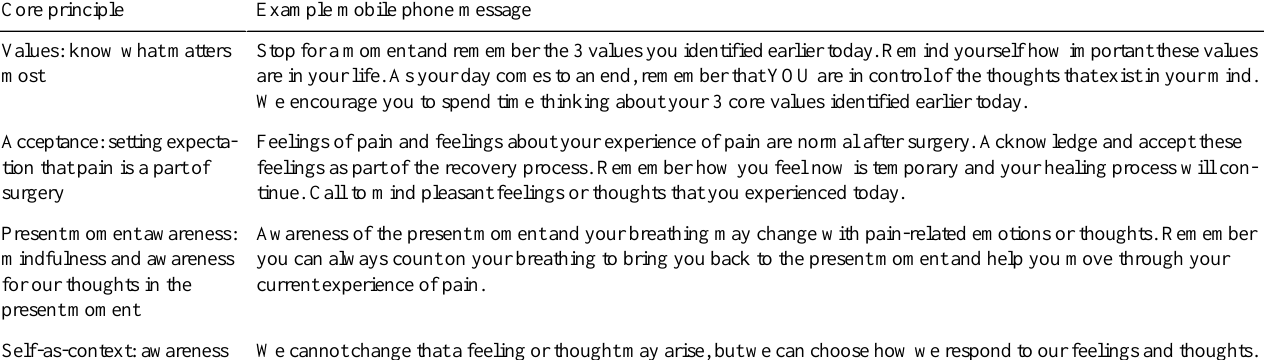
Table 1. Acceptance and commitment therapy core principles with associated messages. Example mobile phone messageCore